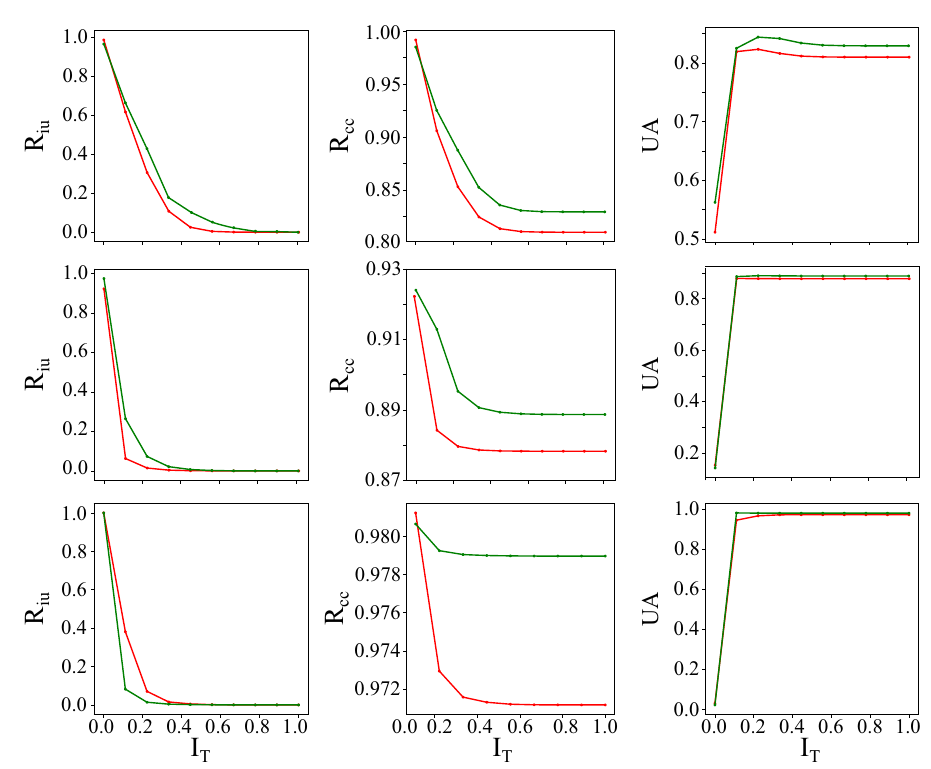
Figure 8. Illustrating the quantitative uncertainty estimation performance for the semantic segmentation task using the proposed evaluation metrics. Note that when varying the uncertainty threshold, our proposed MC-DropConnect approximated BNN (shown in green) generally performs better than MC-Dropout (shown in red) for CamVid (Top) and CityScapes (Middle), and CT-Organ (Bottom)